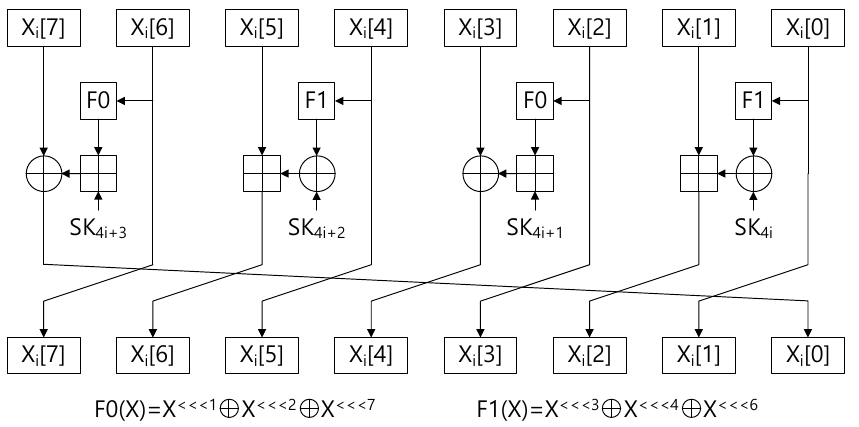
Figure 1. Encryption of the HIGHT algorithm; X and SK indicate plaintext and round key, respec-